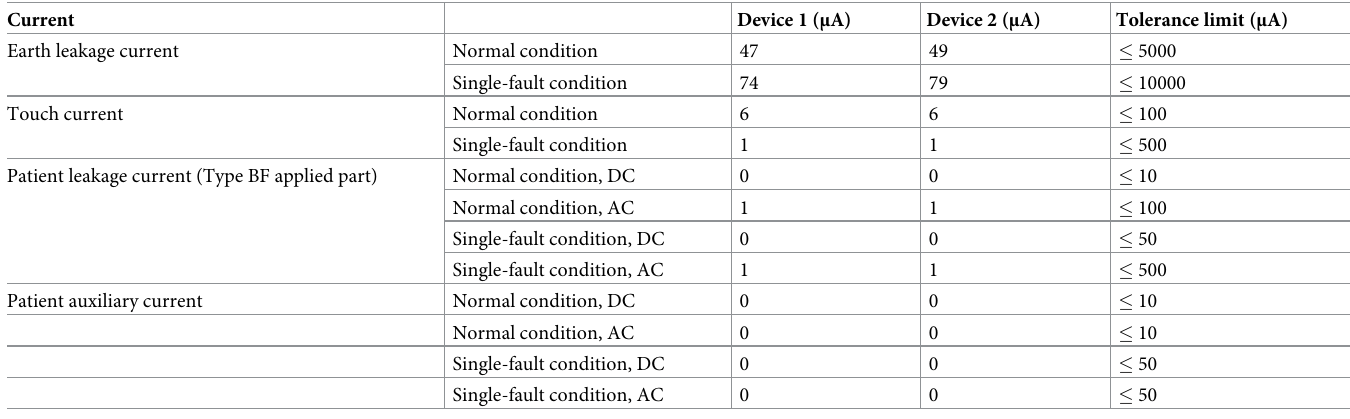
over the highest limit exactly every 10 minutes for 1 minute at three out of four electrodes. It is